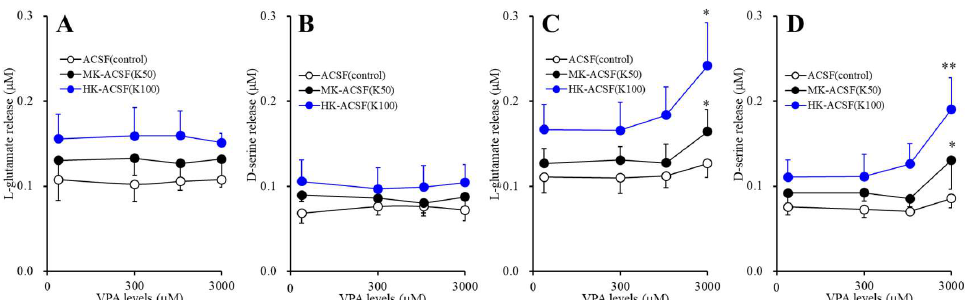
Figure 3. Concentration-dependent effects of acute administration of VPA (valproate) on basal and K + -evoked astroglial releases of L -glutamate ( A ) and d-serine ( B ). After wash-out, astrocytes were incubated in ACSF containing VPA (0, 300, 1000, or 3000 μ M) for 60 min (pretreatment incubation). After pretreatment incubation, to determine the K + -evoked astroglial releases of L-glutamate and D -serine, astrocytes were incubated in ACSF (3.0 mM K + : opened circles), MK-ACSF (50.0 mM K + : closed circles), or HK-ACSF (100.0 mM K + : blue circles) containing the same concentration of VPA during pretreatment incubation for 20 min. Concentration-dependent effects of subchronic administration of VPA on basal and K + -evoked astroglial releases of L -glutamate ( C ) and D -serine ( D ). Astrocytes were incubated in fDMEM containing VPA (0, 300, 1000, or 3000 μM) for 7 days. After wash-out, astrocytes were incubated in ACSF containing the same concentration of VPA (pretreatment incubation). After pretreatment, to clarify the K + -evoked astroglial releases of L -glutamate and D -serine, astrocytes were incubated in ACSF (opened circles), MK-ACSF (closed circles), or HK-ACSF (blue circles) containing the same concentration of VPA during pretreatment incubation for 20 min, and then incubate medium (ACSF, MK-ACSF, or HK-ACSF) was collected for analysis. Ordinate: mean ± SD ( n = 6) of extracellular levels of L -glutamate and D -serine (μM). Abscissa: concentration of VPA ( μ M). * p < 0.05 and ** p < 0.01 vs. VPA free by MANOVA with Tukey’s post hoc test.